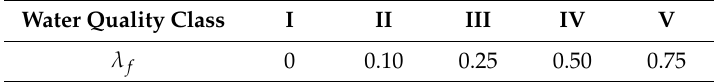
Table 1. Environmental functional loss rate of di ff erent water quality